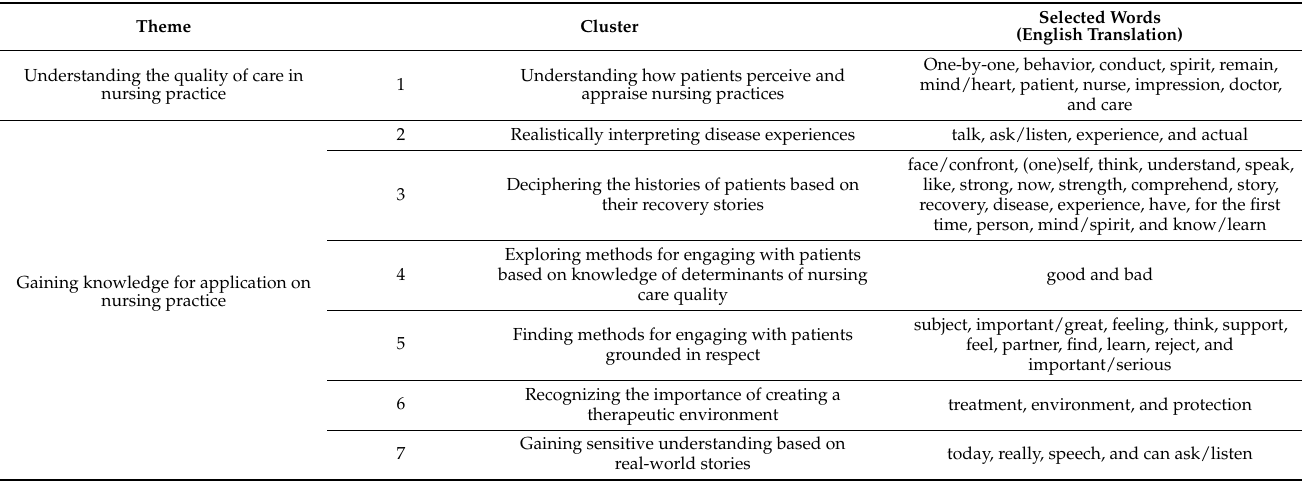
Table 3. A cluster analysis showing themes, clusters, and key words.